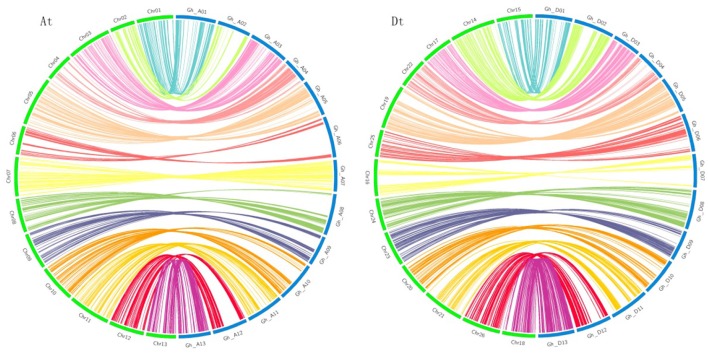
Colinearity between genetic map (green) and physical map (blue). (At) Colinearity for At subgenome. (Dt) Colinearity for Dt subgenome.